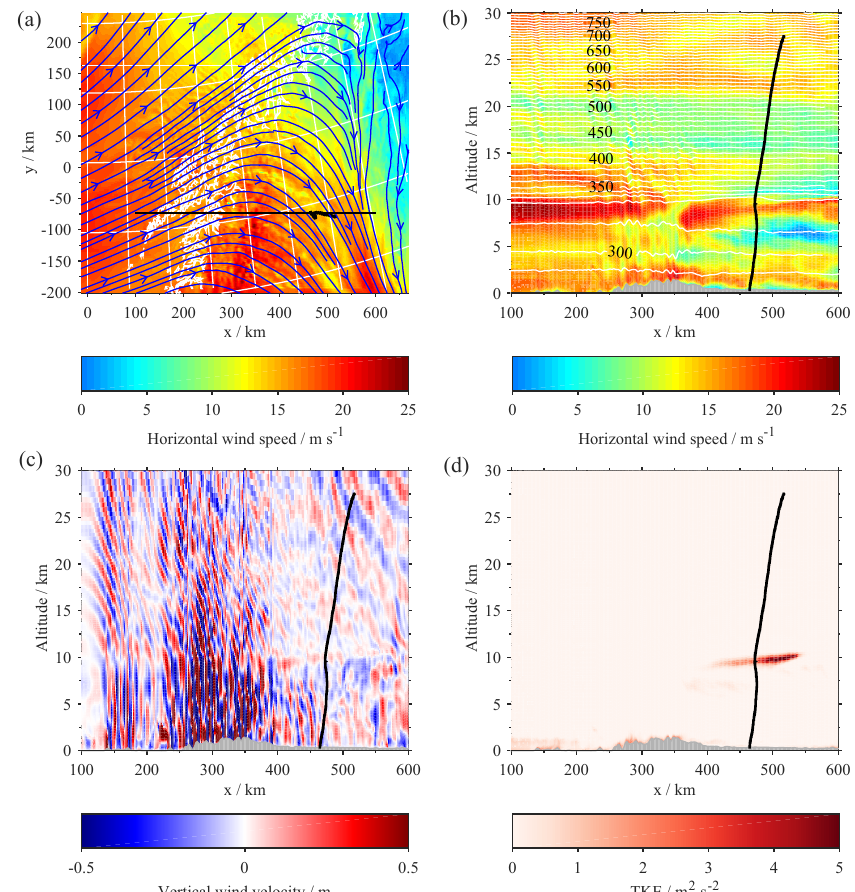
Figure 2. (a) Map of horizontal winds at 850hPa, (b) vertical section of horizontal winds, (c) vertical section of vertical winds, and (d) vertical section of turbulent kinetic energy (TKE) from WRF simulations for 27 September 2011, 18:00UT. The black curves visualise the trajectory of the BEXUS 12 flight. In (a) , the blue streamlines show the wind direction, the white lines visualise coastlines and a latitude/longitude grid, and the black line indicates the location of the vertical sections. In (b) , the white isolines show potential temperature with labels in